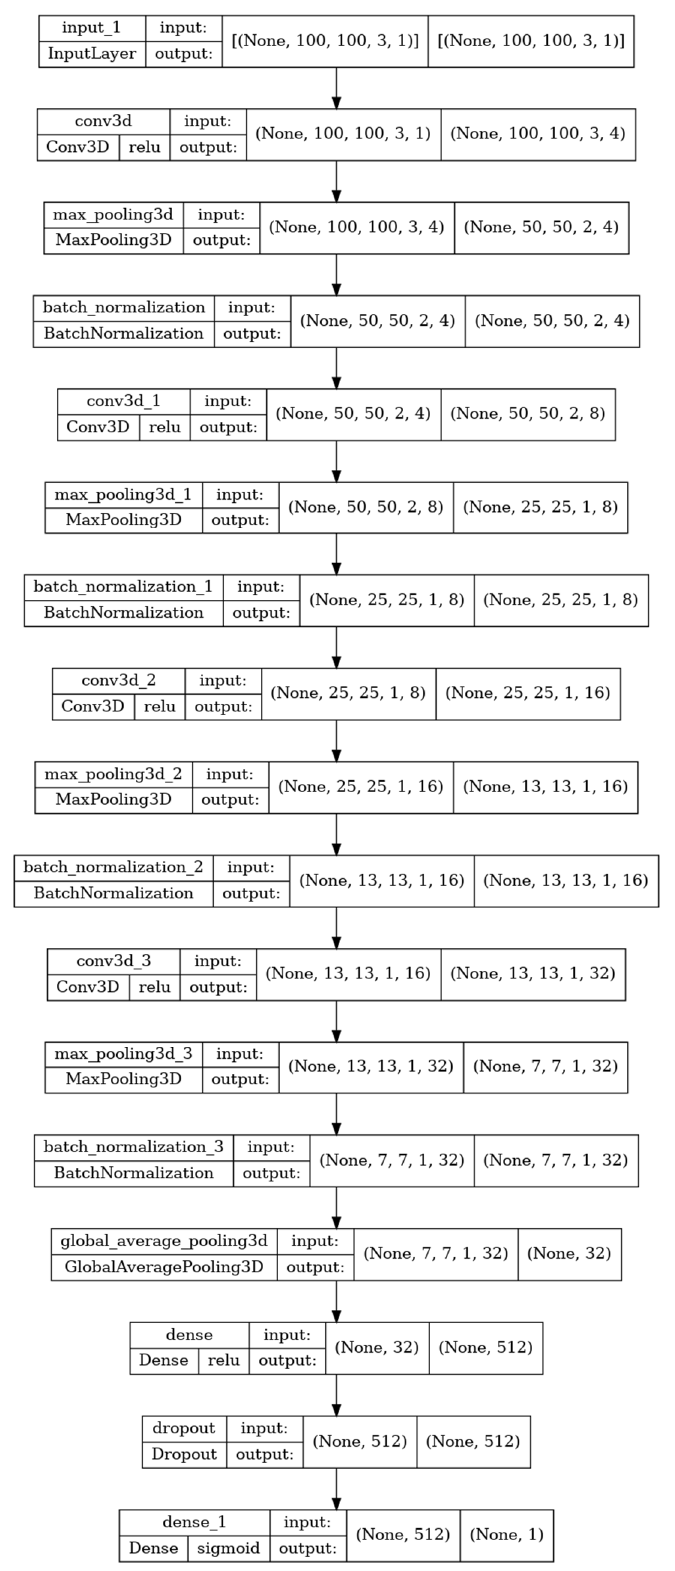
Figure A2. Topology of 3D-CNN utilized for Three-Channel data.